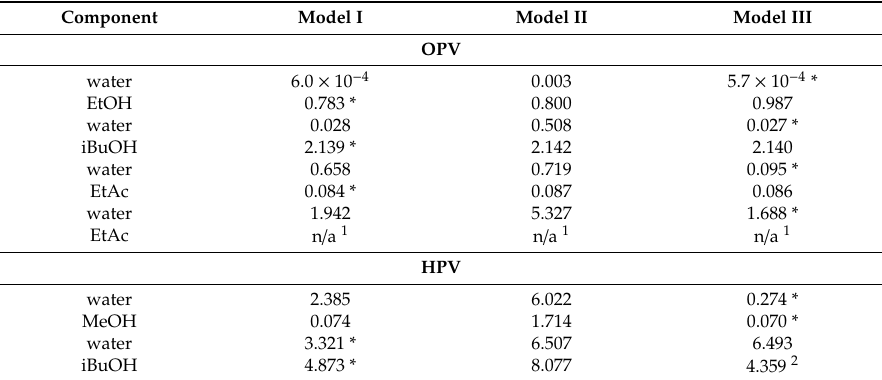
1 Source did not define enough data. 2 Yields unrealistic physical parameter * More accurate